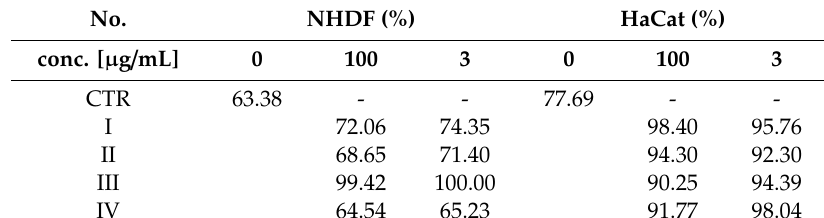
Table 4. Average cell confluence after 72 h.